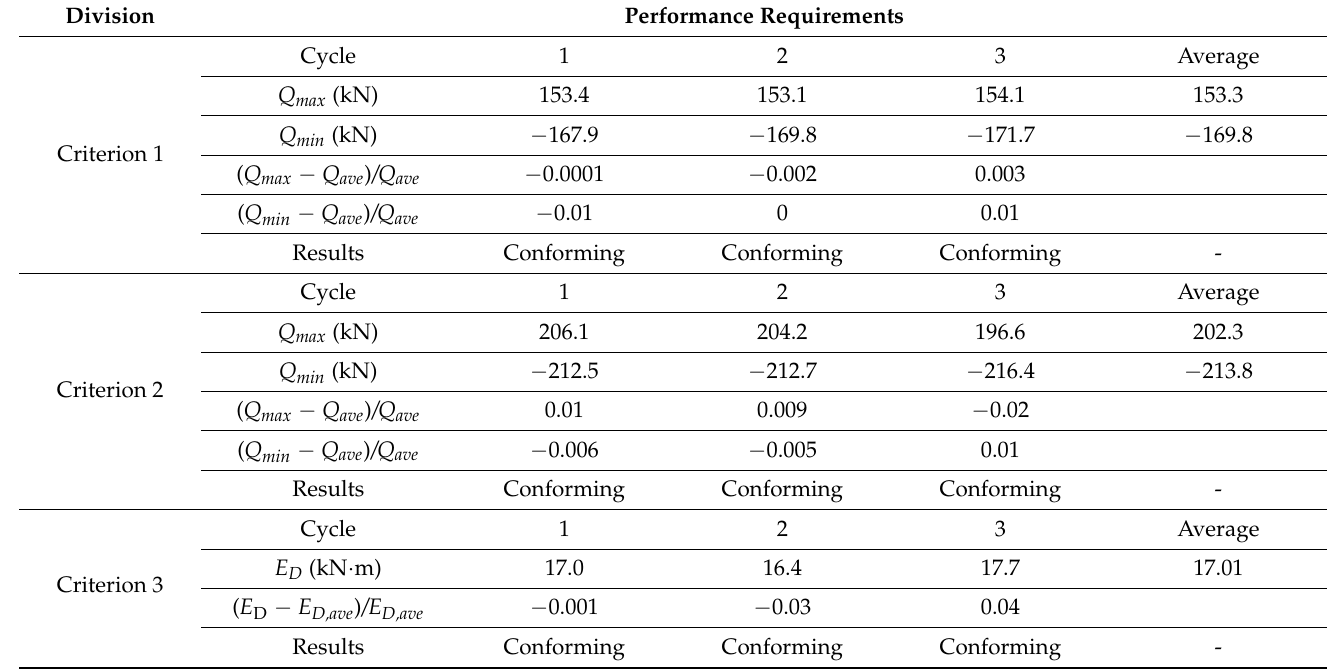
Table 6. Conformance evaluation of NBSD-1 as a seismic control